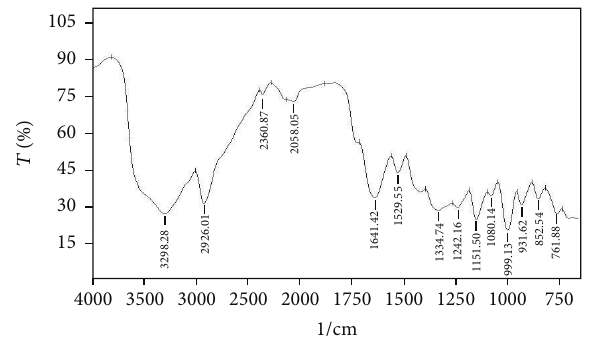
Figure 9: FT-IR spectrum of treated PP after adsorption of BG.